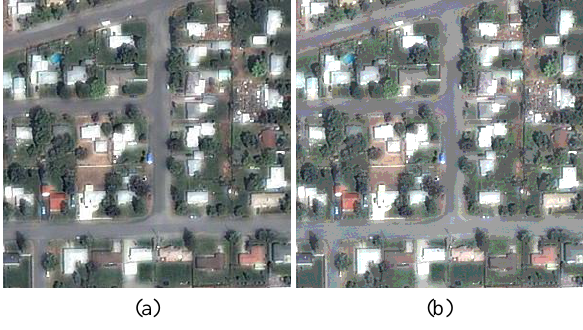
Figure 2. Images before and after gray level compression. (a) before (b) after The performances of proposed method and Apriori algorithm are shown in figure 3. The x axis is support and the y axis is time consuming. The time consuming includes the time from reading image to outputting association rules.